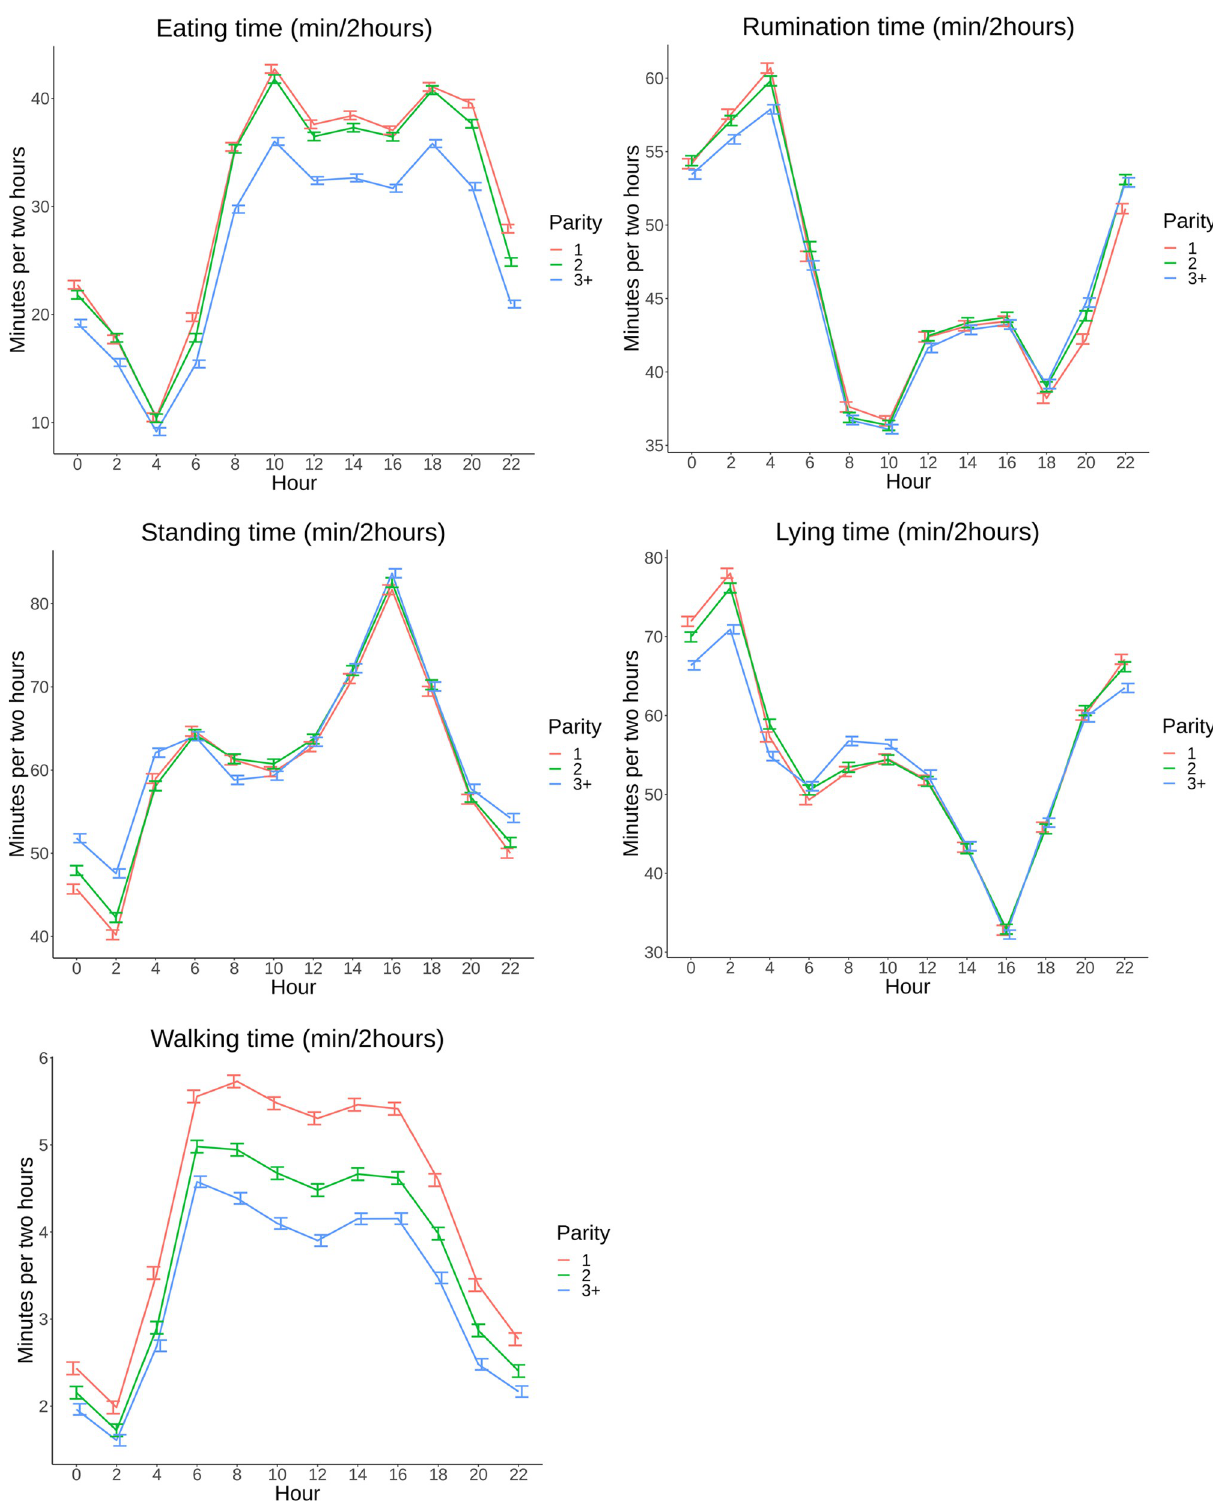
Fig 6. A,B,C,D,E: 24h pattern in minutes per 2 hours (min/2hours) based on least square means (LSM) with 95% confidence intervals (95% CI) grouped by parity: 1, 2 and 3+ on 8 commercial dairy farms in The Netherlands from 00:00AM until 22:00PM.